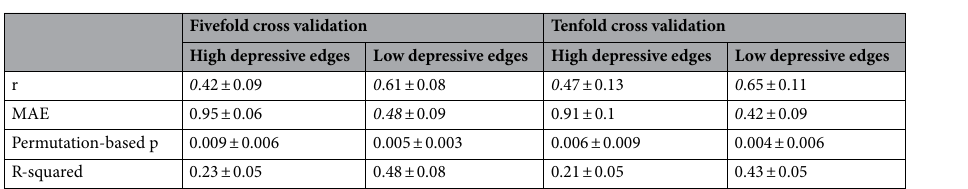
Table 2. Results of the internal validation using fivefold and tenfold cross validations. r denotes the Pearson’s correlation between observed and predicted scores. MAE denotes the mean absolute error of the prediction. R-squared presents the coefficient of